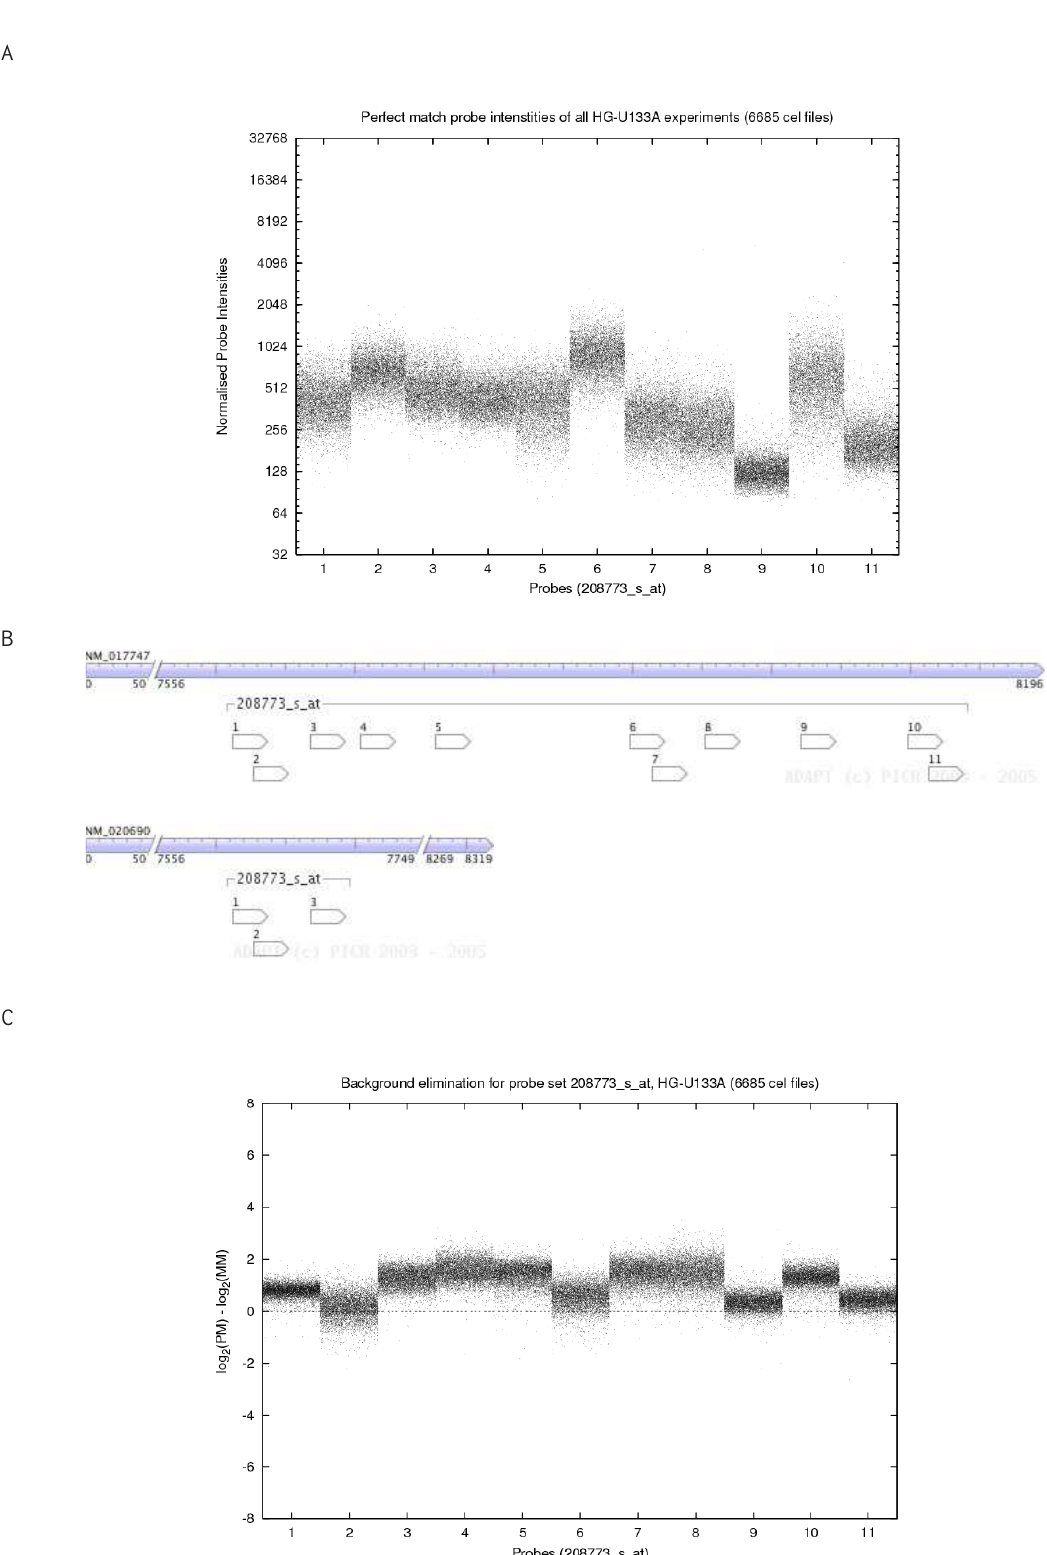
Supplementary Figure 8: Probe intensities over all cel files for probe set 208773 s at on the HG U133A array (A) Perfect match intensities (log scale) (B) ADAPT probe positions on the tran- scripts (C) Background elimination (log 2 (PM) - log 2